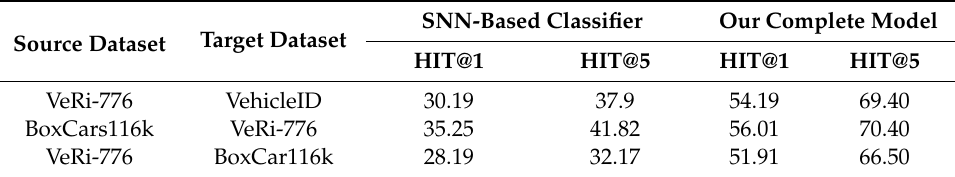
Table 4. Cross-dataset vehicle Re-Id results on di ff erent settings.